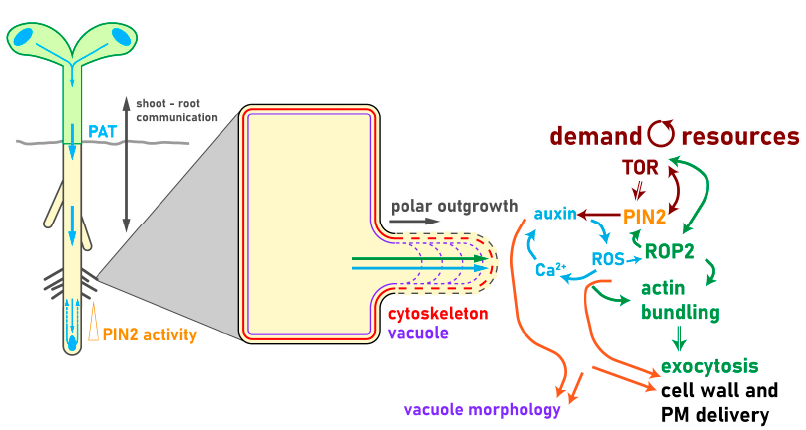
Figure 2. PIN2 orchestrates shootward polar auxin transport as s mediator between exogenous stimuli and root hair outgrowth.